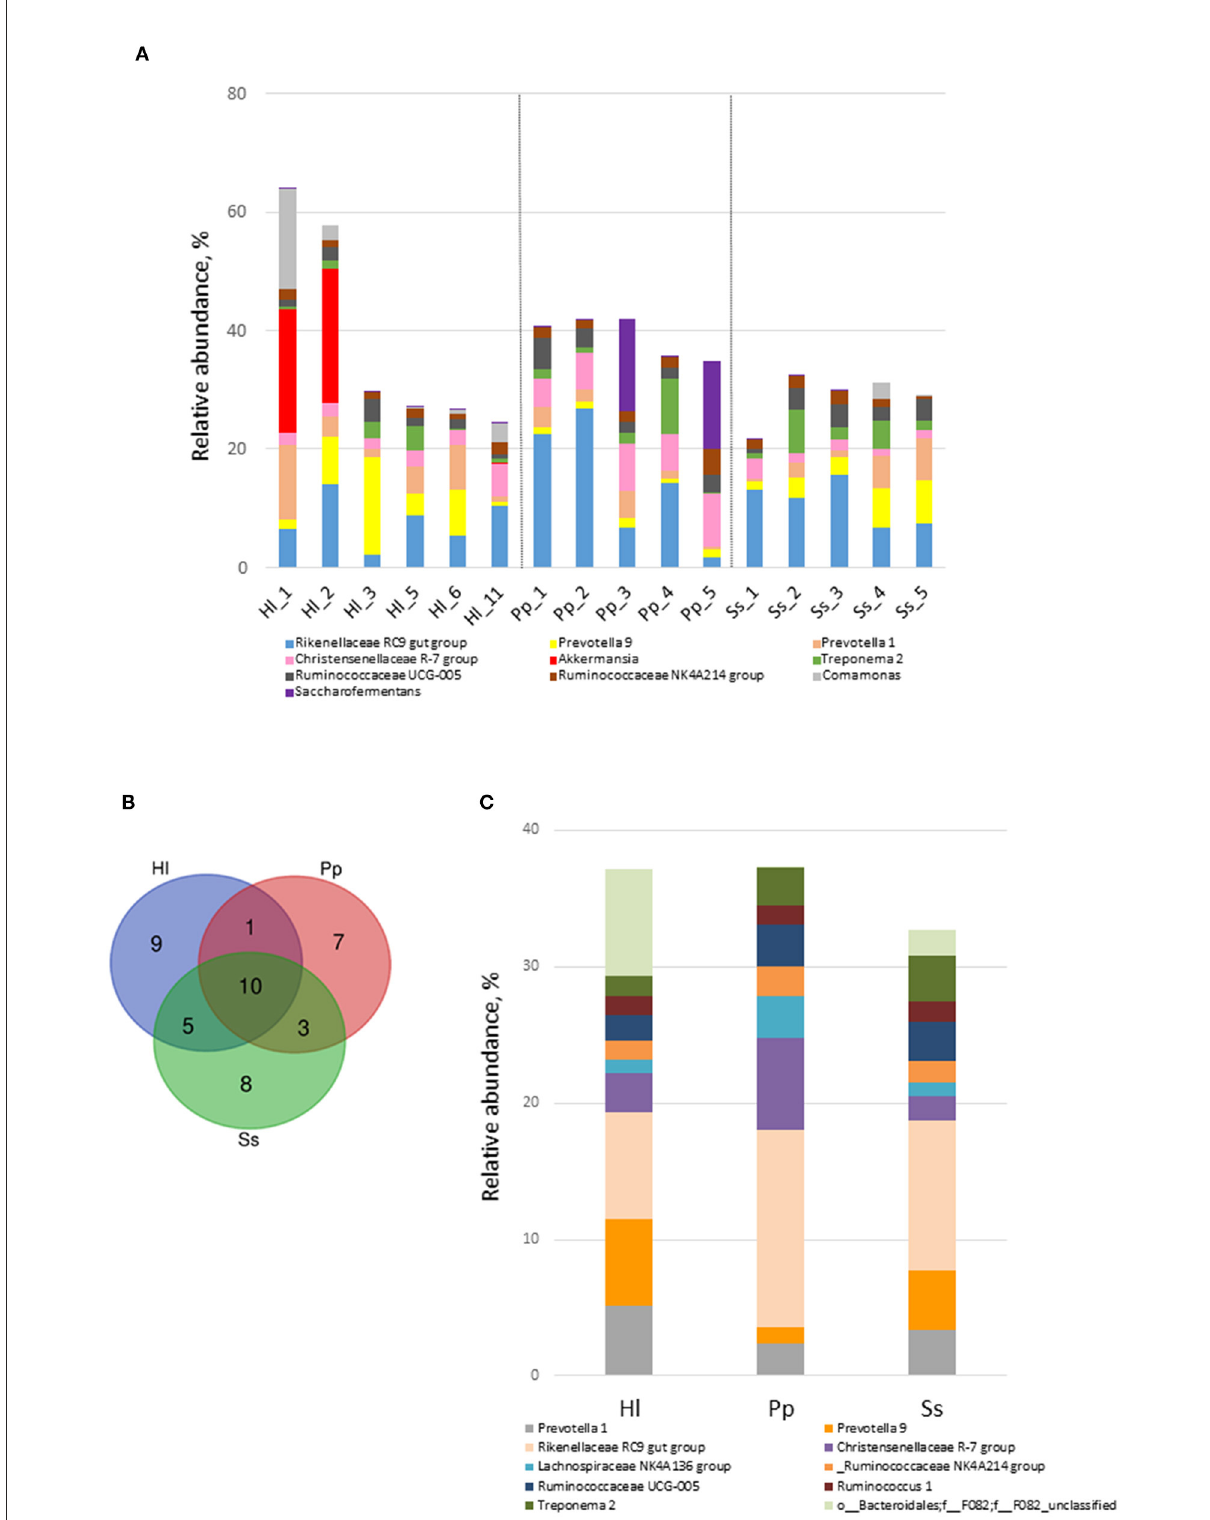
FIGURE2 Shared genera of white-handed gibbons (Hl), Bornean orangutans (Pp), and siamangs (Ss). (A) The top 10 genera and their relative abundance in feces. (B) Venn diagram identified shared genera among the three NHP species inhabiting the Asian tropical rainforest area. Hl, n = 3; Pp, n = 5; and Ss, n = 5. (C) The 10 shared genera and their relative abundance in Hl, Pp, and